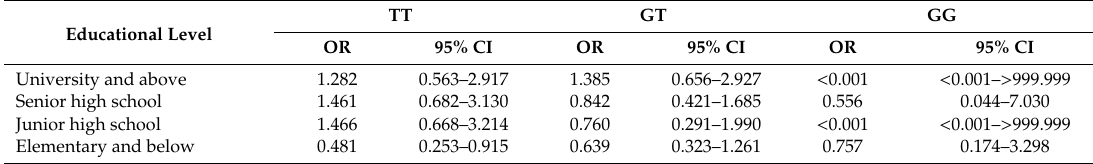
Table 5. E ff ect of sex on MMSE score with respect to educational levels and